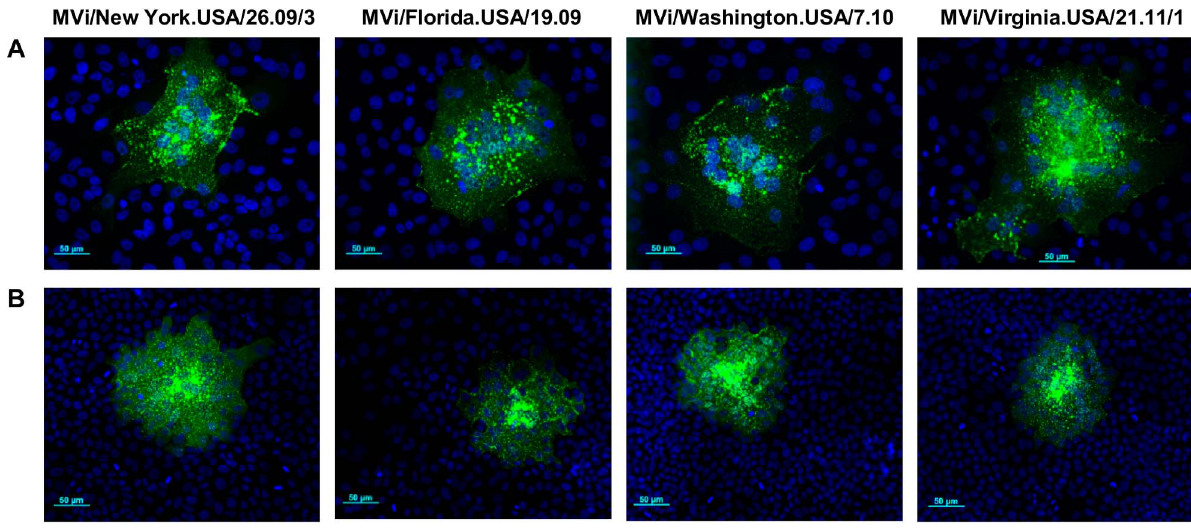
Figure 4. Cytopathic effect and lateral spread of genotype D4 viruses with or without indels. (A) Vero/hSLAM cells and (B) A549/hSLAM cells in chamber slides were infected with MVi/New York.USA/26.09/3, MVi/Florida.USA/19.09, MVi/Washington.USA/7.10 and MVi/Virginia.USA/21.11/ 1. Cells were overlaid with medium containing CMC agarose. Cells were fixed and immunostained 24 hours after infection. Representative fields are shown at 200 6 magnification. Green: MeV nucleoprotein, blue: nuclei.